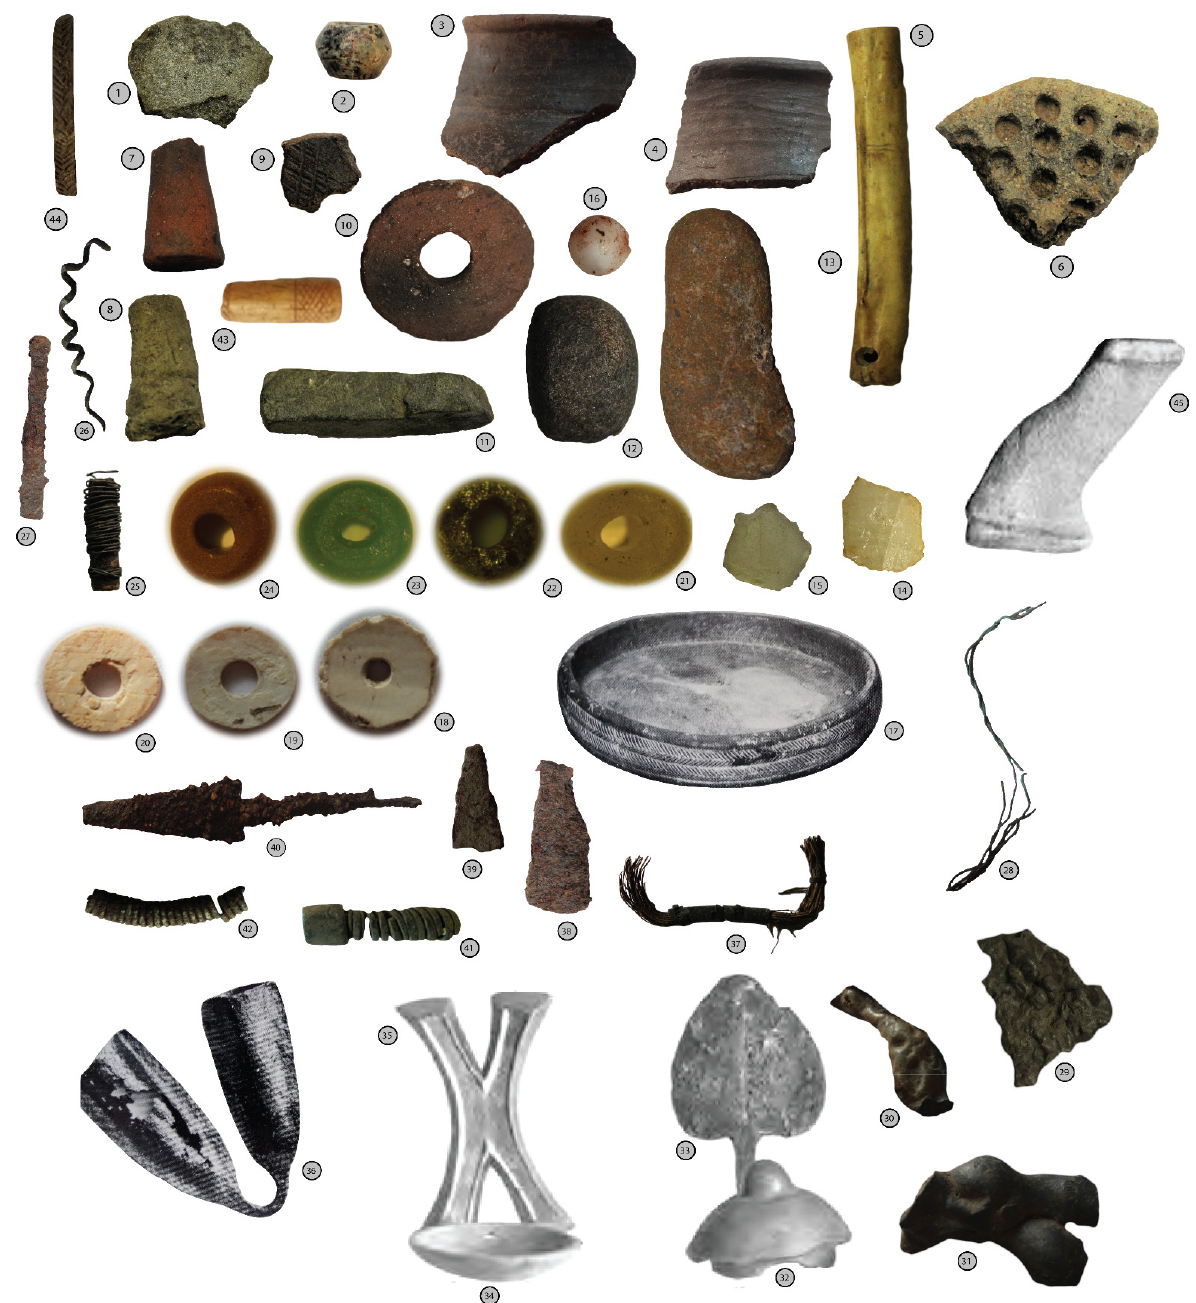
Figure 5. Some of the crafts and import objects that were recovered from Zimbabwe tradition sites in Mberengwa. 1 = soapstone slab, 2 = soapstone bead, 3–4 = Zimbabwe tradition pottery sherds, 5 = bone whistle, 6 = clay gold bead mold, 7–8 = clay figurines, 9–10 = spindle whorls, 11–16 = lithics, 17 = soapstone bowl (originally from Great Zimbabwe; typical bowls were recovered at Chumnungwa and Mundi), 18–20 = shell beads, 21–24 = glass beads, 25 = bronze wire bangle with hollow bone core, 26, 28 = cuprous wound wire, 27 = Mbira iron key, 29–31 = slag, 32 = clay (pot) lid, 33, 38, 39 = iron hoe heads, 34, clay bowl, 35 = copper X ‐ shaped ingot, 36 = double iron gong (originally from Great Zimbabwe; a similar gong was recovered at Chumnungwa), 37 = bronze wound bangle with a fiber core, 40 = iron arrowhead fragment, 41–42 = bronze wound wire bangles, 43 = dice, 44 = bronze bangle fragment with herringbone pattern, 45 = soapstone hammer (adapted from